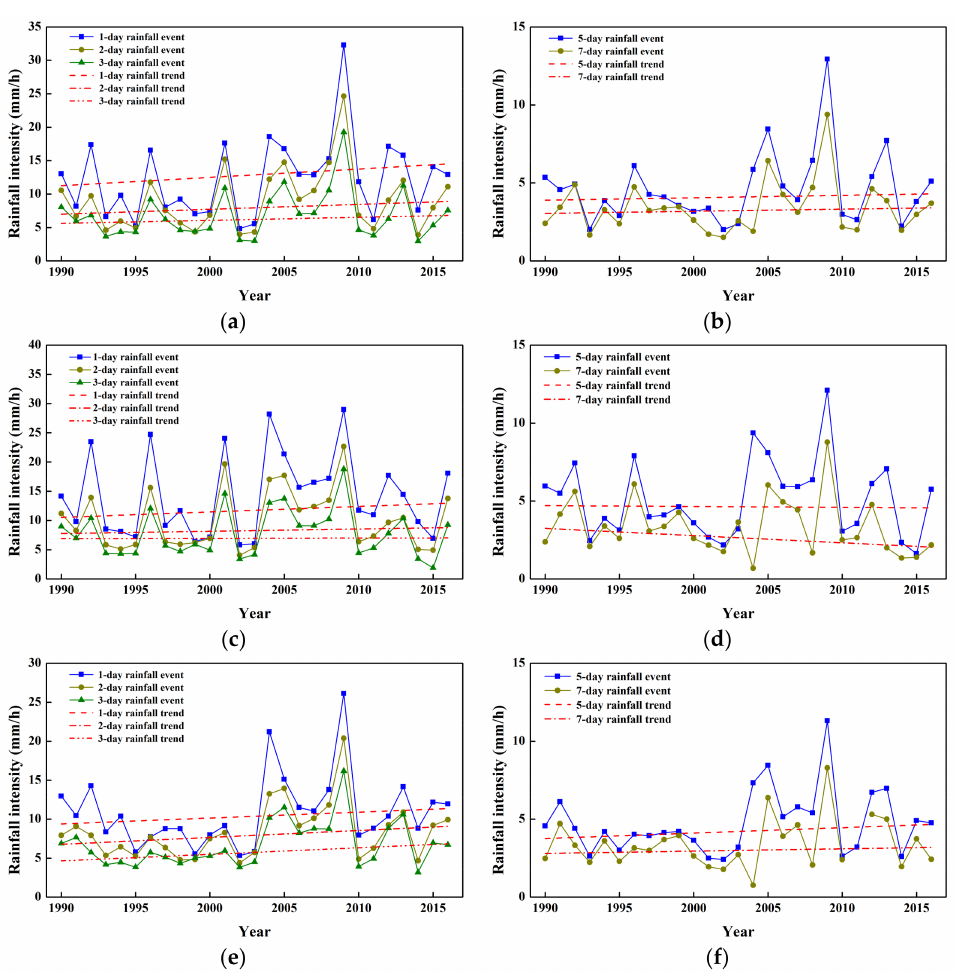
Figure 4. Rainfall intensity variation patterns from 1990 to 2016: ( a ) 1, 2 and 3 day rainfall events at Da-Dong-Shan rainfall station; ( b ) 5 and 7 day rainfall events at Da-Dong-Shan rainfall station; ( c ) 1, 2 and 3 day rainfall events at Ma-To-Shan weather station; ( d ) 5 and 7 day rainfall events at Ma-To-Shan rainfall station; ( e ) 1, 2 and 3 day rainfall events at San-Jiao-Nan-Shan rainfall station; ( f ) 5 and 7 day rainfall events at San-Jiao-Nan-Shan rainfall